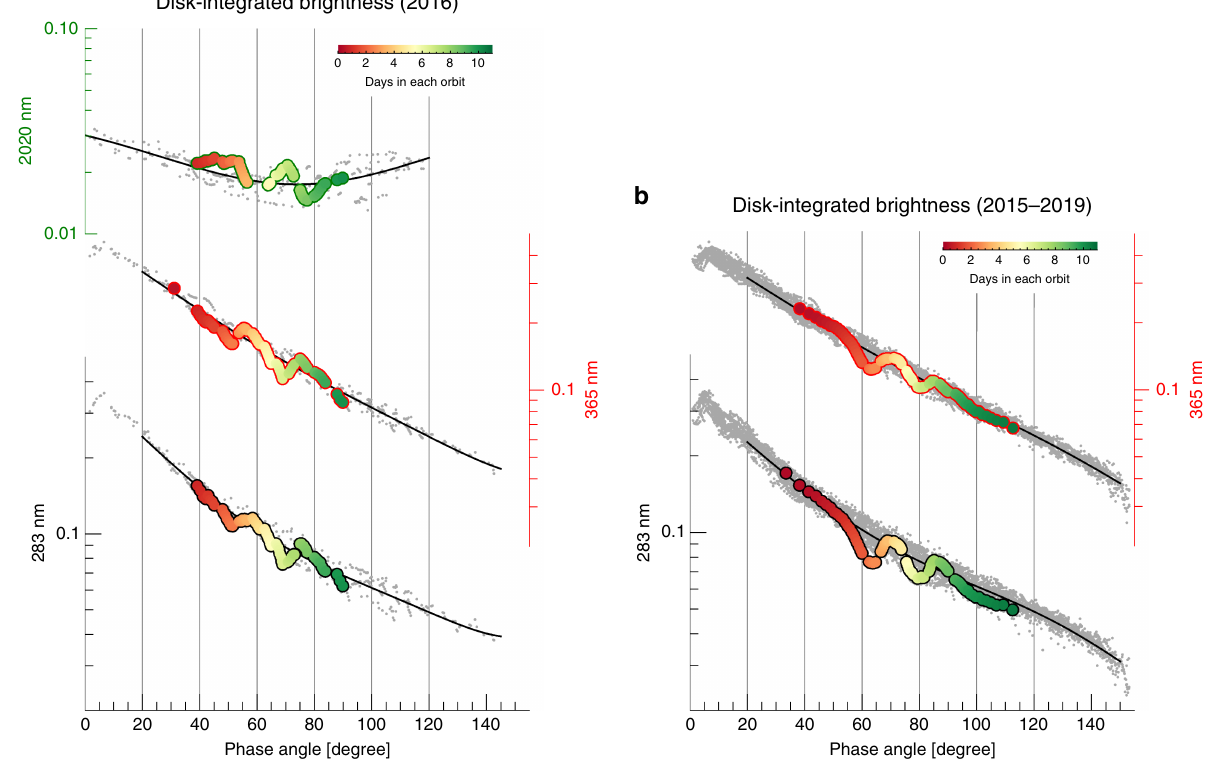
Fig. 1 Venus phase curves over time. The color bars indicate Earth days within one orbit (~11 days). The solid black lines are best- fi tting 4-degree polynomials for each dataset, which we use as baselines to investigate temporal variations. a From top to bottom, brightness at 2020, 365, and 283 nm between March 31 and October 29, 2016 (gray dots). The largest temporal variation occurred on orbit 20 (color symbols) (See also Fig. 2). b UV brightness from Dec 2015 to Jan 2019 (gray dots). Unusually high brightness variations occurred on orbit 81 (color